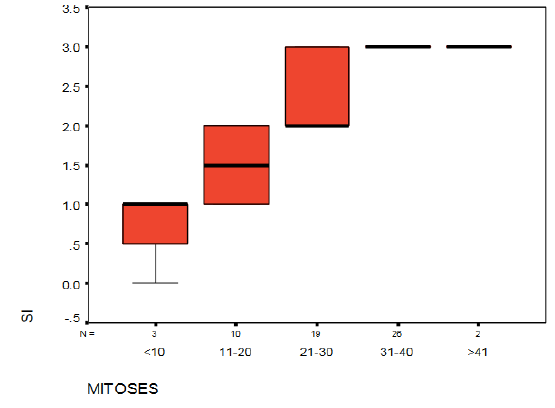
Figure 3. COX-2 expression in different Clark levels. Figure 4. The relationship between the SI score and